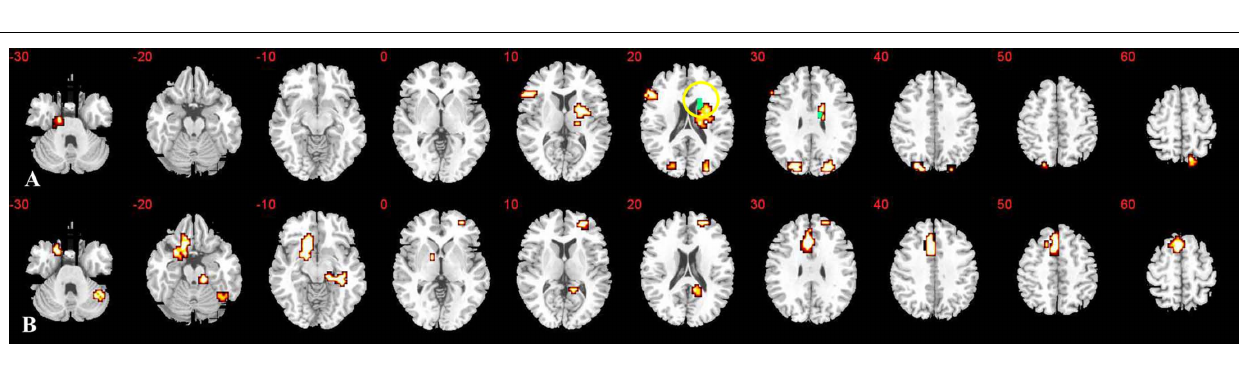
FIGURE 3 |Whole-brain correlation of activation with age: clusters exhibiting linear positive (A) or negative (B) correlation with age across all subjects. Statistical threshold selected to elicit less than one error cluster (at p < 0.05 for voxel and p < 0.05 for